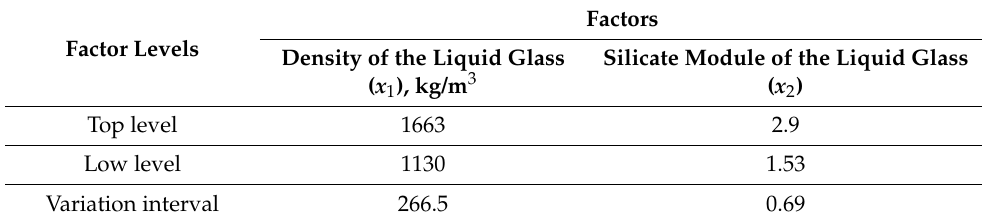
Table 6. Conditions for changing